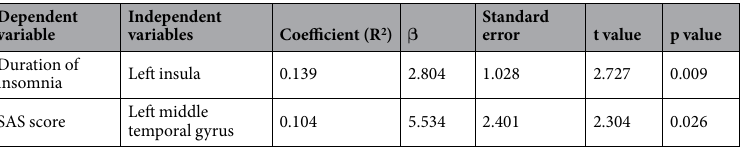
Table 3. Multiple linear regression analysis between binarized degree centrality and behavioral performances in PIs. Abbreviations: PIs, patients with primary insomnia; SAS, Self-rating anxiety scale.